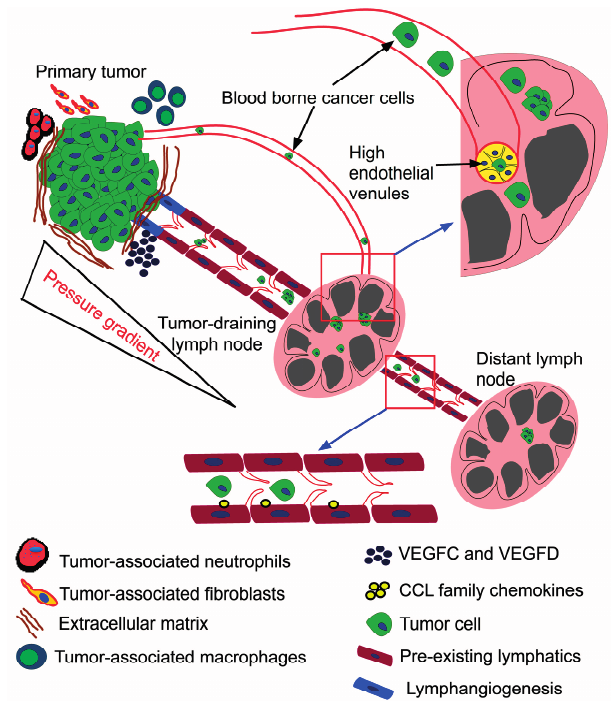
Figure 1. How do cancer cells reach the tumor-draining lymph nodes (TDLN)? The primary tumor microenvironment is regulated by the interactions between tumor cells, extracellular matrix (ECM), tumor-associated neutrophils and fibroblasts. These interactions induce the secretion of vascular endothelial growth factors C and D (VEGFC and VEGFD) that mediate the formation of new lymphatic capillaries around the primary tumor. Cells from the primary tumor travel through the lymphatics either as single cells or as clusters in response to the pressure gradient. Chemokine attractions facilitated by chemokine ligands (CCL) family chemokines secreted by endothelial cells and chemokine receptors (CCR) family receptors expressed on tumor cells can also facilitate the translocation of tumor cells through the lymphatic capillaries. The translocated cells get lodged in the TDLN to form micrometastases. Alternatively, cells from the primary tumor can enter the peripheral circulation and reach the TDLN through the high endothelial venules in the